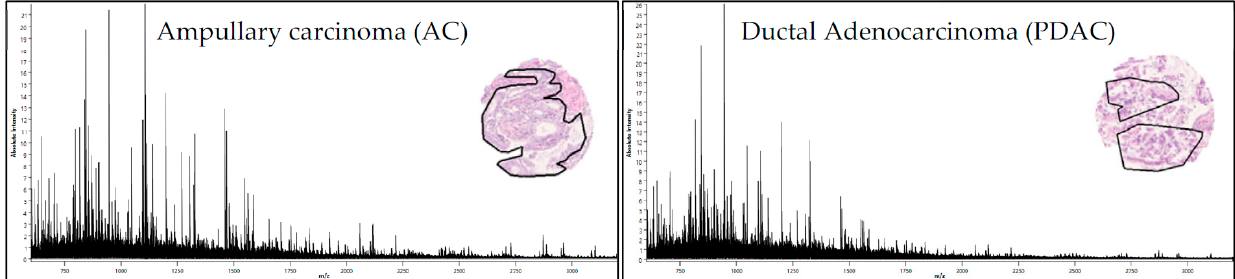
Figure 2. MALDI-MSI derived signature. Average spectra (435 m / z values) from AC ( left ) and PDAC ( right ) tumor regions (black line in the H&E staining of representative tissue cores).